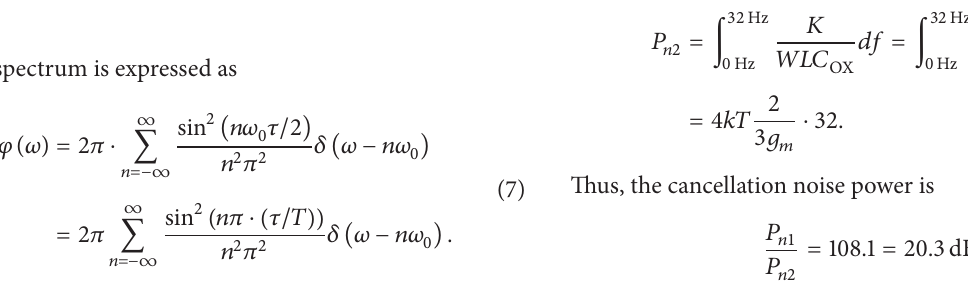
Figure 9: DC amplifier circuit with low frequency servo